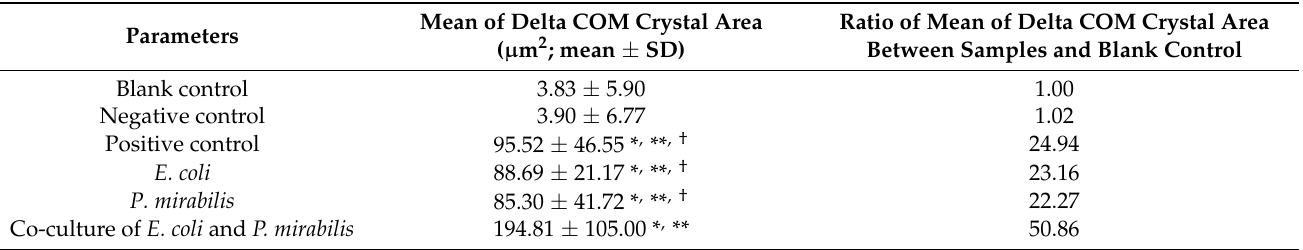
Table 2. Effect of bacteria on COM crystal growth under microaerobic